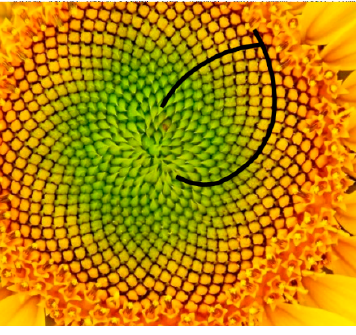
Figure 20. Spirals in the sunflower.